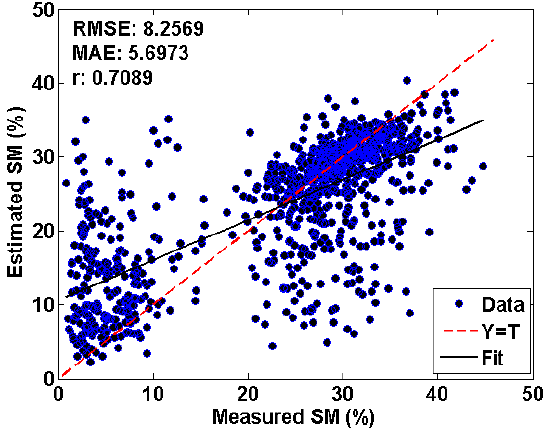
Figure 17. The relationship between measured and estimated SM for combined Datasets 1&2&3.